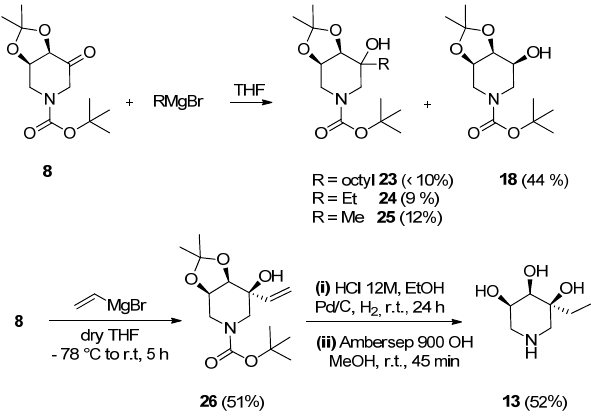
Table 1. Addition reactions of lithium acetylides to ketone 8